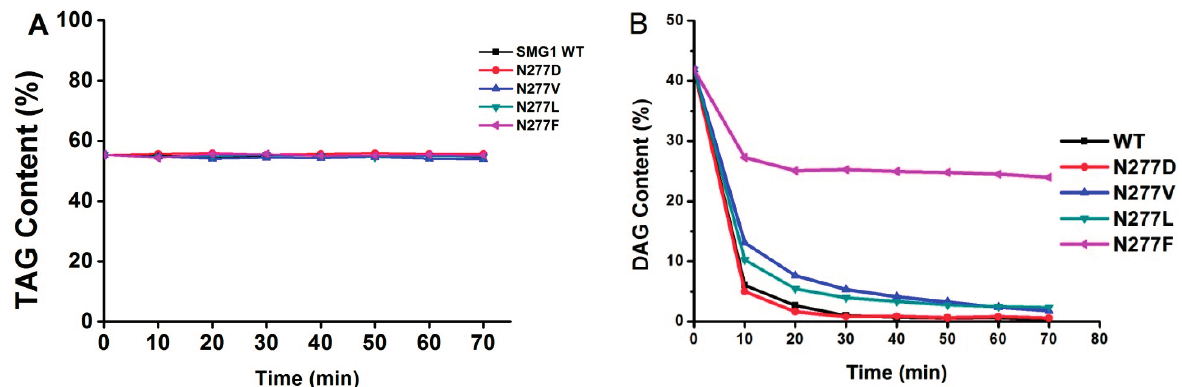
Figure 4. Time course of hydrolysis of acylglycerols (mixture of TAG and DAG) by SMG1 and its mutant. Reaction conditions are as follows: Enzyme load, 6.7 U/g of acylglycerols substrate; Temperature, 25 °C; Reaction time, 70 min; Water, 25% with respect to total reactants; Agitation speed, 200 rpm; ( A ) TAG contents; ( B ) DAG contents.